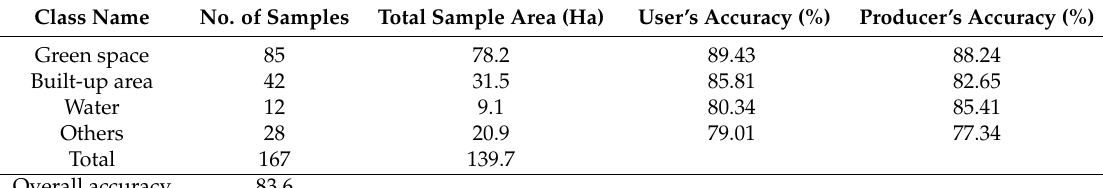
Table 5. Accuracy assessment of the classified map of